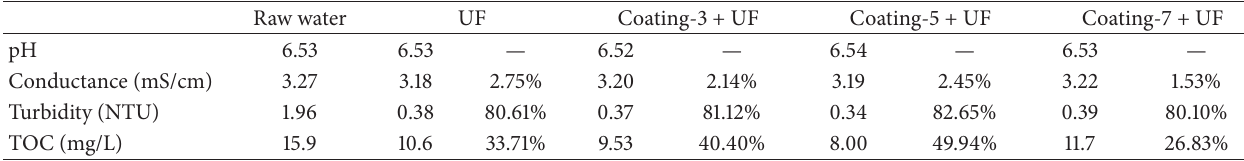
-film photocatalysis (10KDa). 2